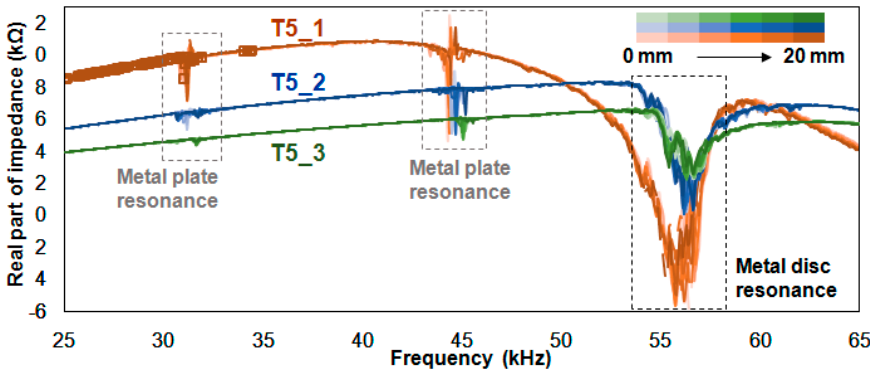
Figure 8. Impedance signatures for the T5_1, T5_2 and T5_3 experiment.